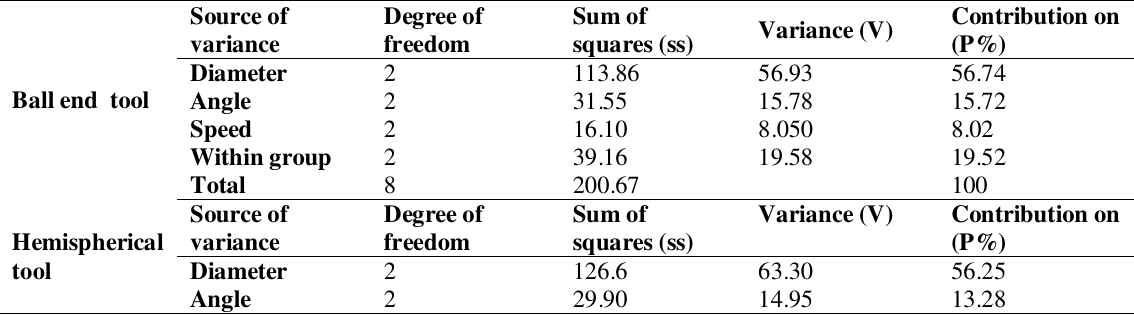
ANOVA results of the residual stresses